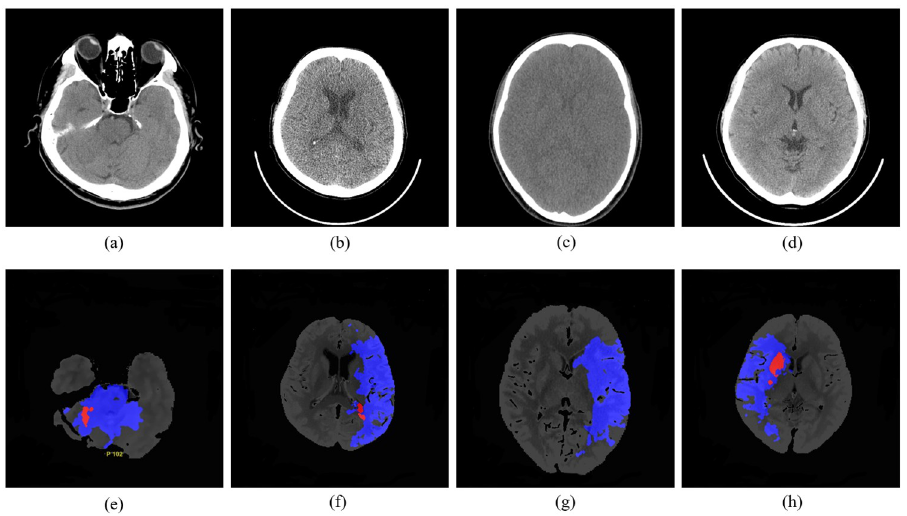
Fig 1. Examples of nCCT images, (a)-(d), and the corresponding CTp, (e)-(h). The color shows the cerebral blood volume (CBV), cerebral blood flow (CBF), the mean transit time (MTT) generated by CTp, the ischemic area- blue, the dead tissue-red.